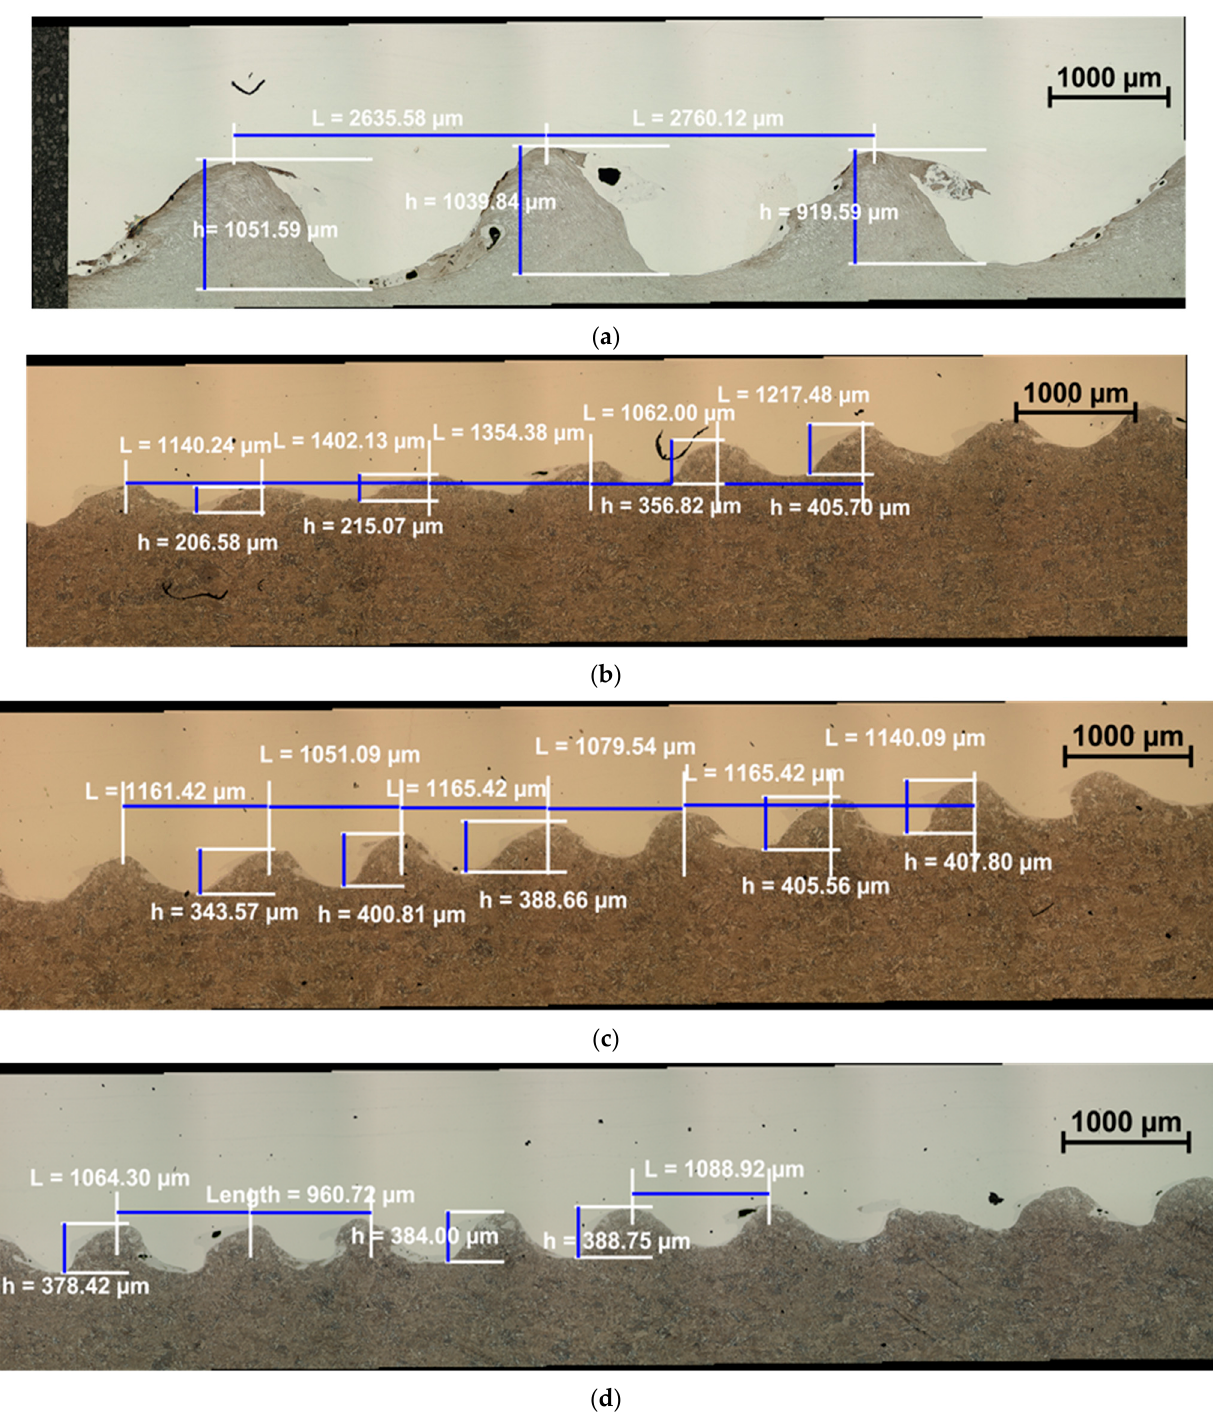
Figure 12. Microstructure of the joint area of X2CrNiMo17-12-2 + 10CrMo9-10 bimetallic sheet metals ( a ) bimetallic material after direct connection, ( b ) after asymmetric rolling for a v = 0.75, ( c ) after asymmetric rolling for a v = 0.8, and ( d ) after rolling for a v =